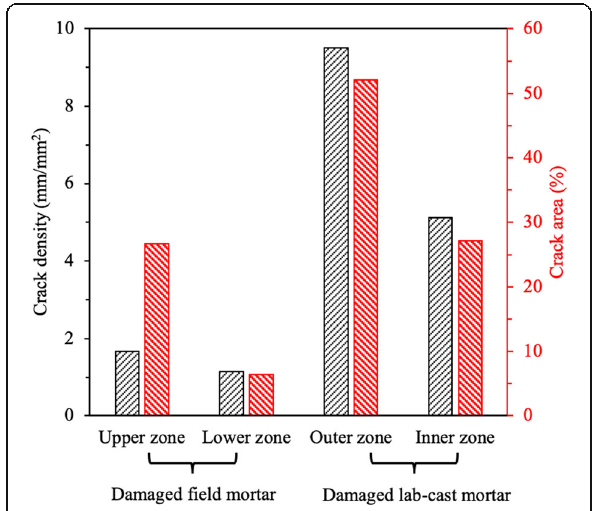
Fig. 6 Crack density (left series) and crack area fraction (right series) in different zones of the damaged field mortar and lab-cast mortar